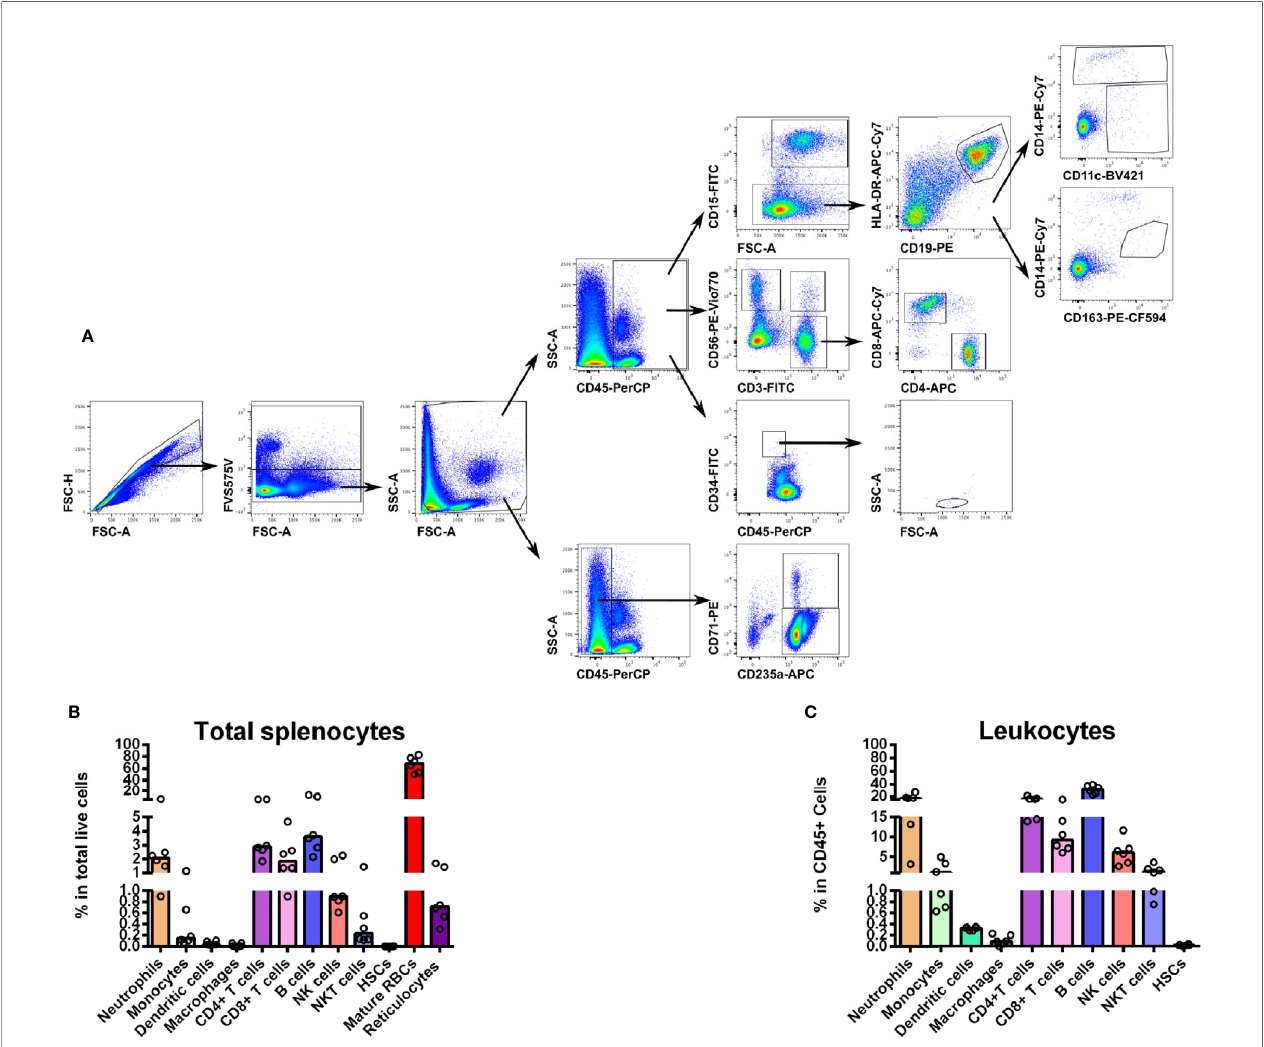
FIGURE 1 | (A) Hierarchical multiparameter fl ow cytometry gate strategy for human spleen cells immunophenotyping. Total spleen cells obtained in suspension after mechanical tissue disruption were assessed for viability and phenotyped using surface markers for several populations. First, singlets were selected by gating events in the diagonal of FSC-H vs. FSC-A plots. Live cells were gated out from the positively stained population with FVS575V viability marker. This total live cell population was then divided in CD45 + and CD45 - to differentiate whole leukocytes and erythroid cells, respectively. Reticulocytes (CD235a + CD71 + ) and mature RBCs (CD235a + CD71 - ) were gated in CD45 - cells. From the CD45 + population we gated neutrophils (CD15 + ), B cells (CD15 - CD19 + HLA-DR + ), monocytes (CD15 - CD19 - HLA-DR +/- CD14 + CD11c +/- ), total DCs (CD15 - CD19 - HLA-DR +/- CD14 - CD11c + ), macrophages (CD15 - CD19 - HLA-DR +/- CD14 med CD163 + ), T cells (CD3 + CD56 - ), NK cells (CD3 - CD56 + ), NKT cells (CD3 + CD56 + ), CD4 + T cells (CD3 + CD56 - CD4 + CD8 - ) and CD8 + T cells (CD3 + CD56 - CD4 - CD8 + ). We gated hematopoietic stem cells as a CD45 med CD34 + population with a low SSC and medium FSC. (B) Distribution of total spleen cells. Frequencies of the different spleen populations, de fi ned as described above were quanti fi ed. (C) Distribution of total spleen leukocytes. Plots represent the median of six different human spleens analyzed